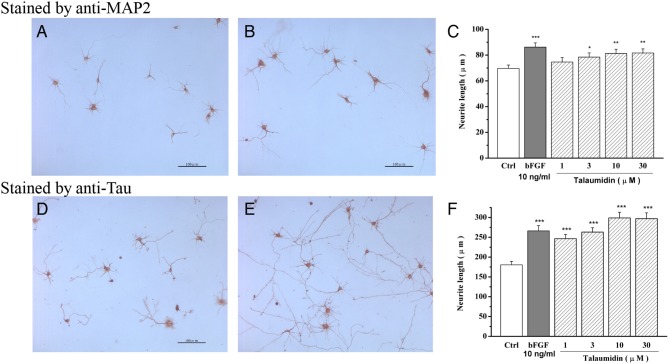
Neurite outgrowth-promoting activity of 1 shown by anti-MAP2 and anti-tau immunohistochemical staining in primary cultured rat cortical neurons. (A,D) Morphology of neurons in control groups, (B,E) Morphology of neurons in 10μM talaumidin groups, (C,F) quantitative analysis of dose-dependent manner. *P < 0.05, **P < 0.01, ***P < 0.001 compared with control (Ctrl) (Zhai et al., 2004).